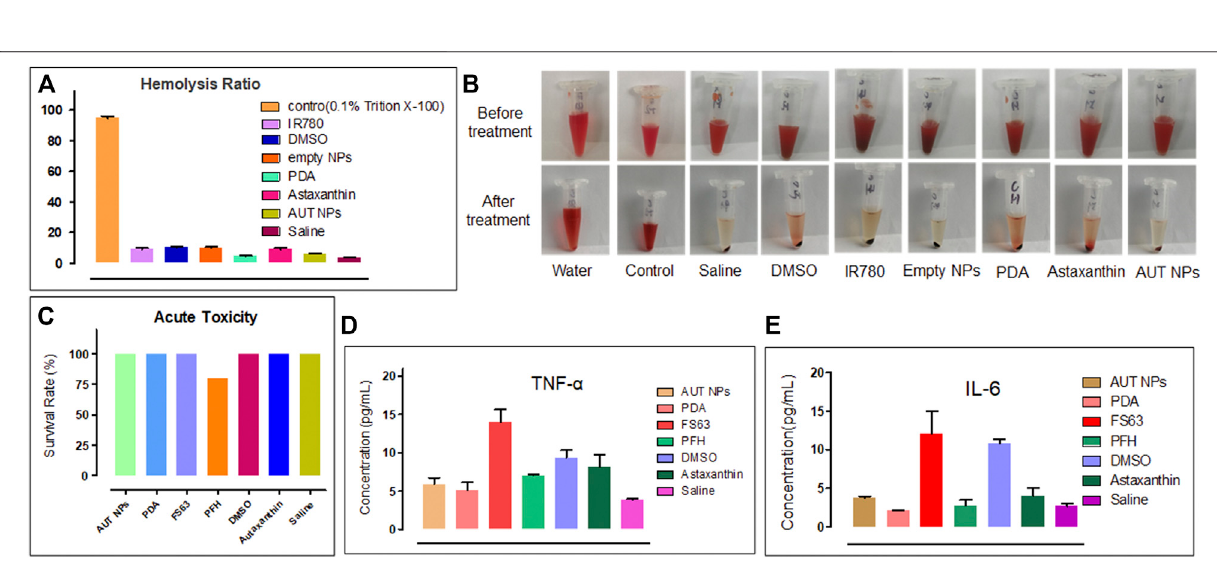
Frontiers in Chemistry |